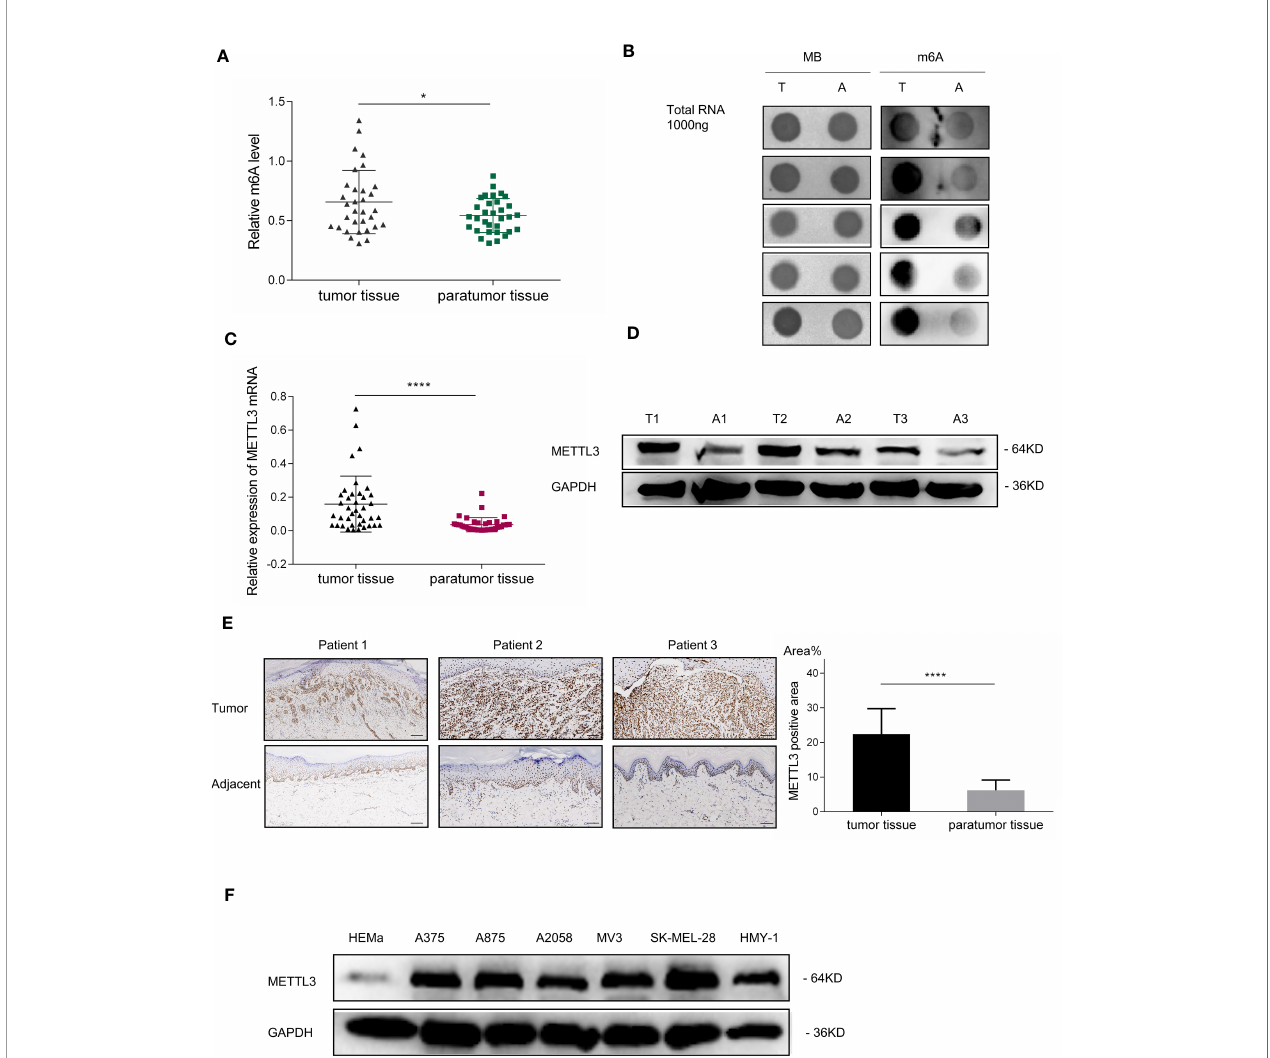
FIGURE 1 | m 6 A RNA methylation level and METTL3 expression in patients with melanoma. (A) Global m 6 A quanti fi cation of total RNA from 32 melanoma specimens demonstrated the elevation of m 6 A levels in tumor tissues; scatterplot displays statistical results. Bar charts show the mean ± SD of each group (n = 32). (B) Dot blot of total RNA extract from fi ve pairs of melanoma tumor tissues and adjacent normal tissues stained with an anti-m 6 A antibody. Methylene blue represents loading control of RNA samples. (C) METTL3 expression in melanoma tumor and adjacent normal tissues determined via qRT- PCR. Bar charts show the mean ± SD of each group (n = 34). (D) Western blotting con fi rmed METTL3 upregulation in melanoma. GAPDH served as a loading control. (E) IHC revealed masses of METTL3-positive cells in AM tumor tissues. Relatively negative staining was observed in adjacent normal tissues. Bar = 100 m m. Bar chart shows the mean ± SD of each group (n = 12). (F) Western blot analysis indicated that METTL3 protein levels of HEMa were lower in melanoma cells. Data are presented as the mean ± SD from at least three biological replicates, with *p < 0.05, and ****p < 0.0001 indicating the signi fi cance